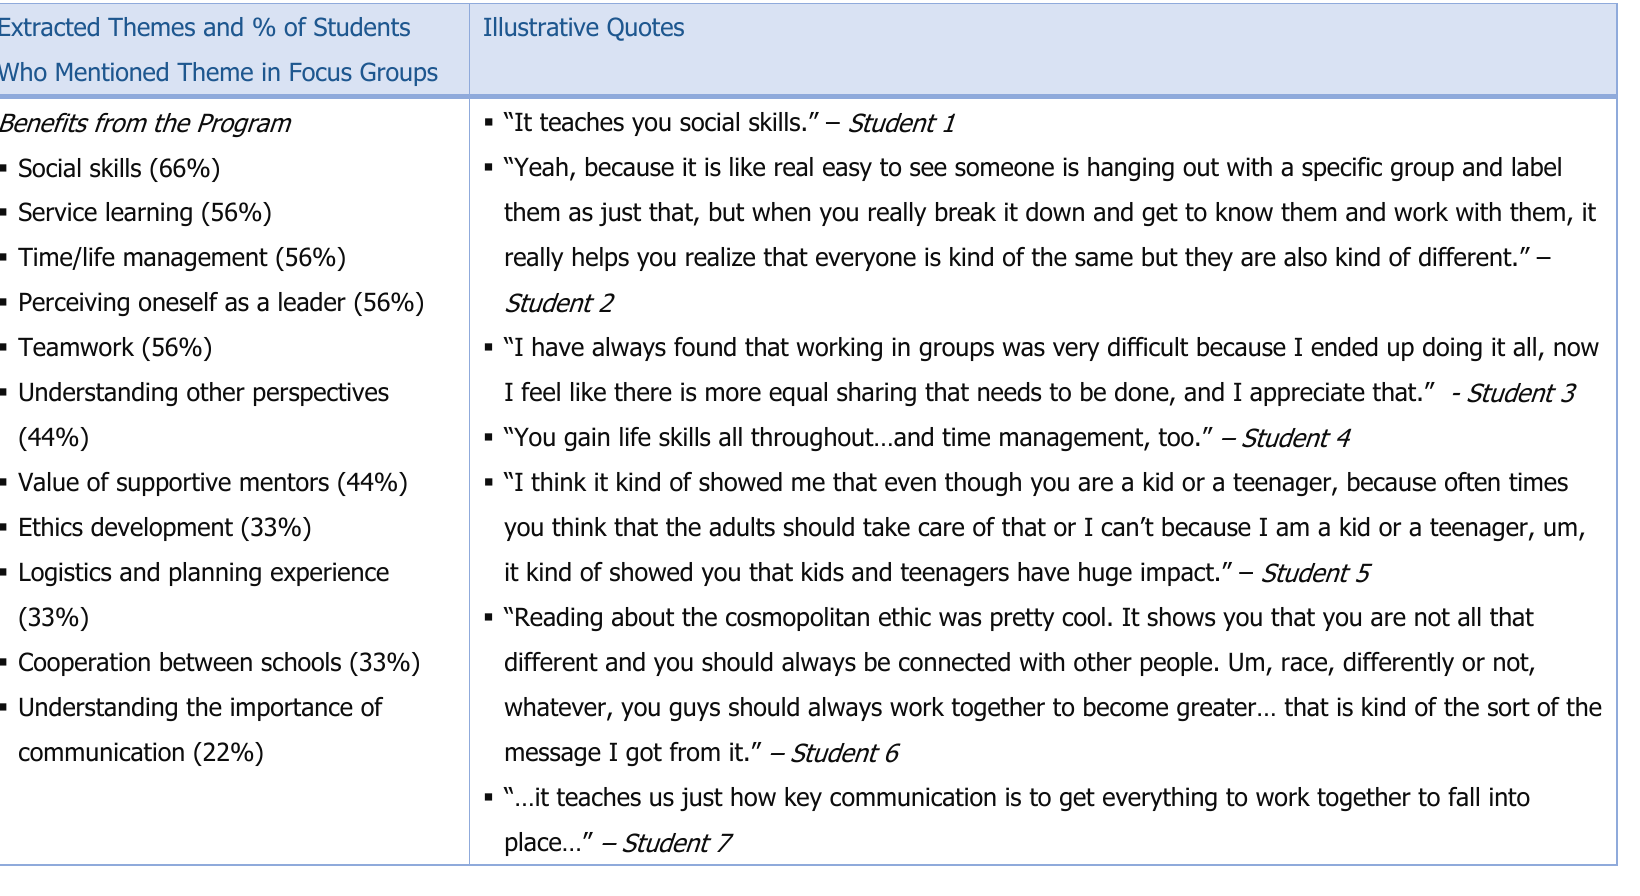
Table 3: Focus Group Discussion Themes, Their Frequencies, and Illustrative Quotes Extracted Themes and % of